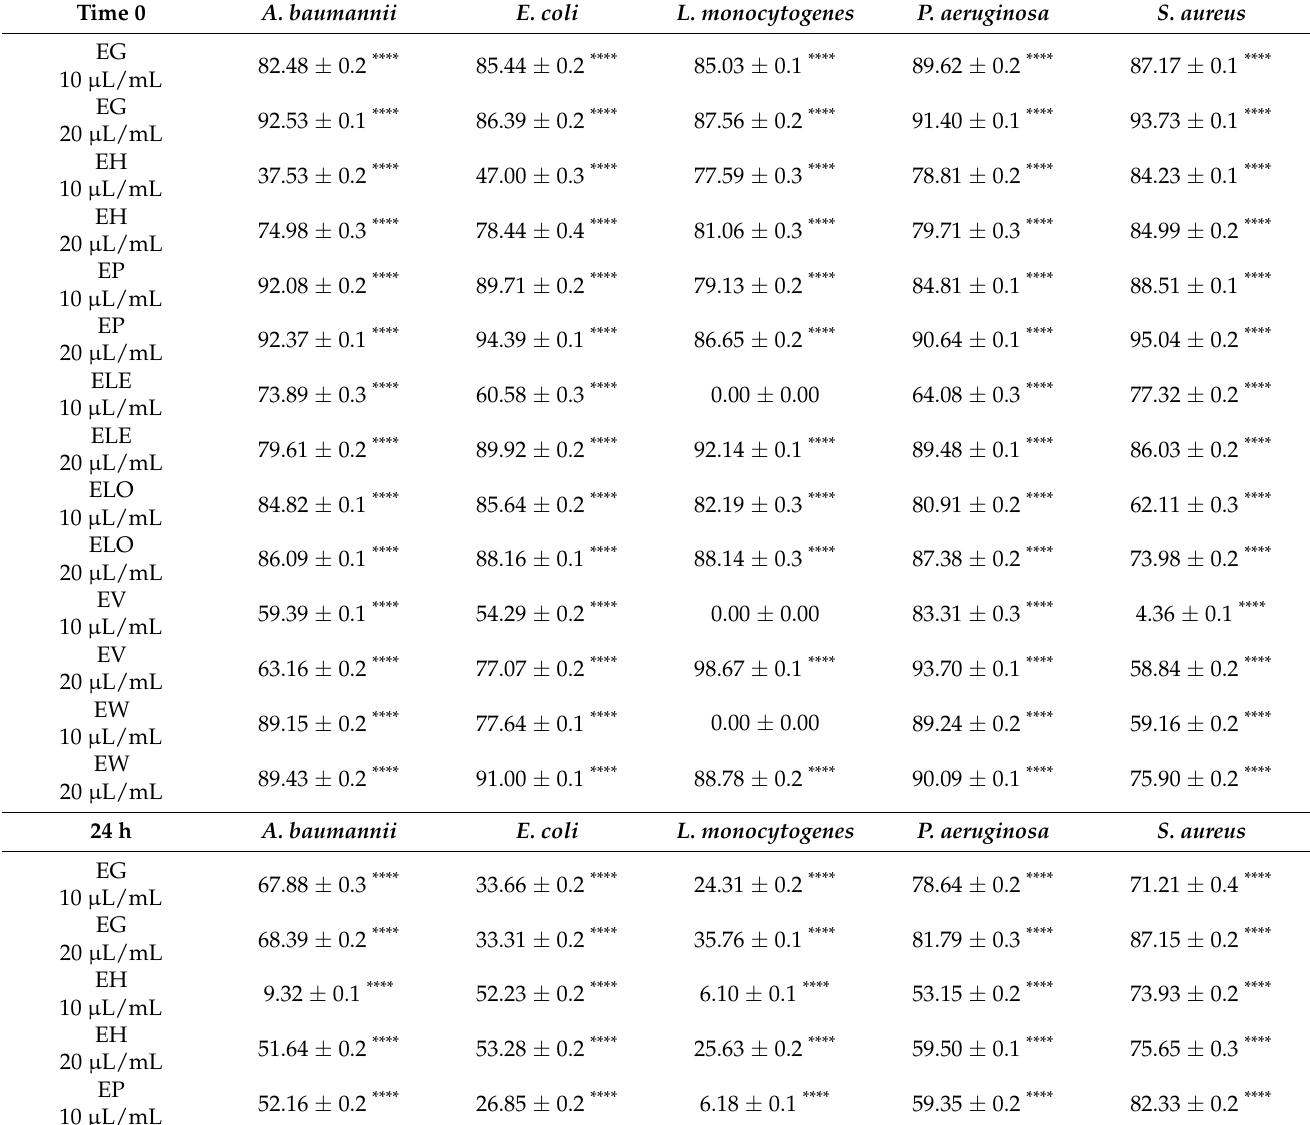
Table 4. Inhibitory activity of the EOs on the biofilm, at 0 and 24